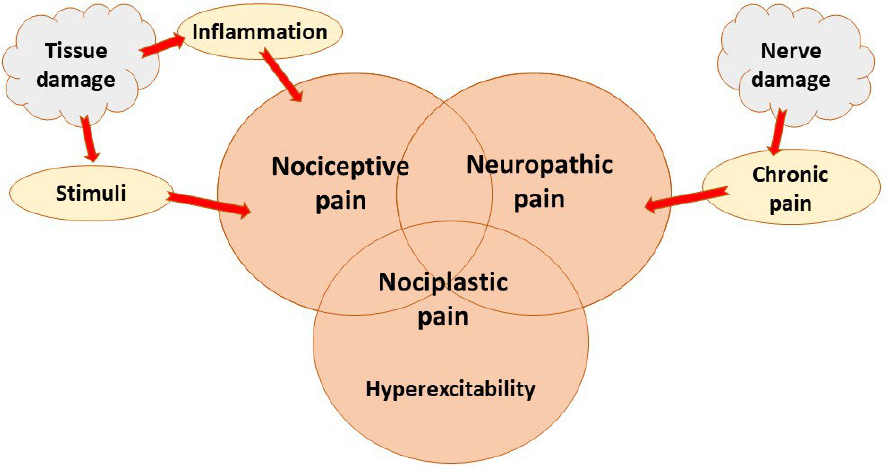
Figure 1. Main pain types.